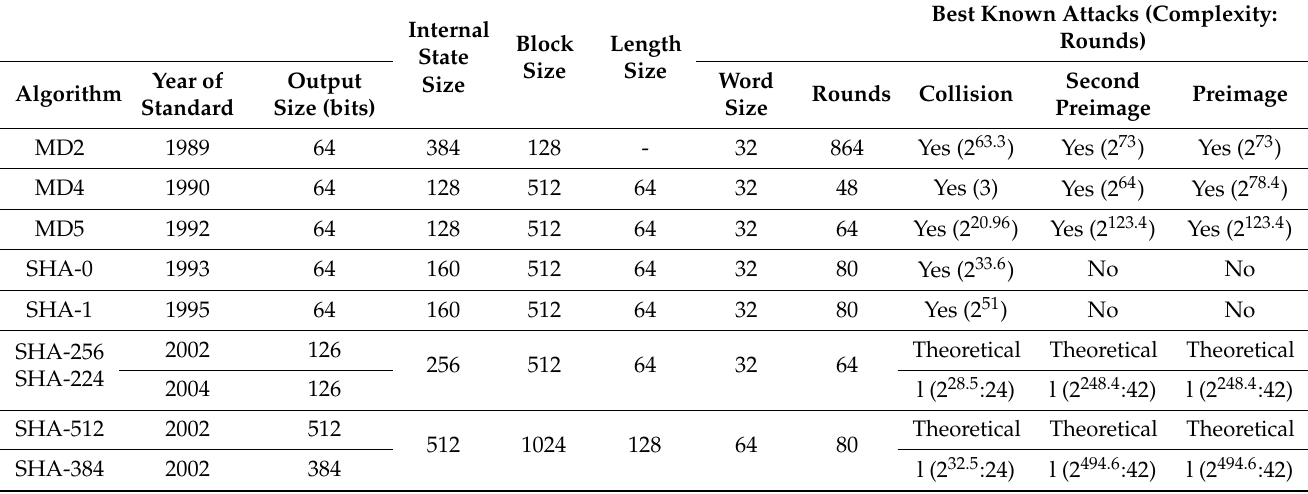
Table 1. Comparison of various white box cryptographic hash